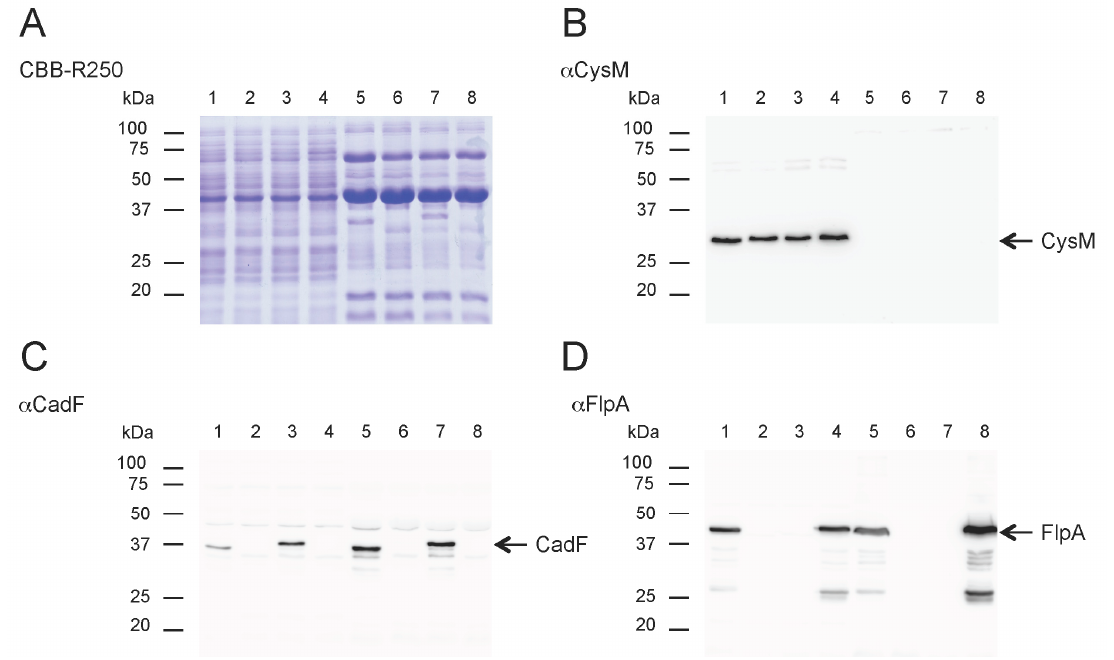
Figure 4. CadF and FlpA are localized in the outer membrane protein (OMP) extracts of the C. jejuni transformed isolates. C. jejuni whole-cell lysates (WCL) and OMP extracts from C. jejuni wild-type, the ∆ cadF ∆ flpA isolate, and the ∆ cadF ∆ flpA isolate complemented with cadF or flpA were subjected to SDS-PAGE and immunoblot analysis with rabbit α -CadF, α -FlpA, and α -CysM-specific sera. Panels: ( A ) proteins were stained with Coomassie Brilliant Blue R-250 (CBB-R250) to show equal loading; ( B ) immunoblot probed with the α -CysM serum, a cytosolic protein used to assess the purity of the OMP extracts; ( C ) immunoblot probed with the α -CadF serum; and ( D ) immunoblot probed with the α -FlpA serum. Lanes: C. jejuni strains (1) 81-176 (wild-type), WCL; (2) ∆ cadF ∆ flpA , WCL; (3) ∆ cadF ∆ flpA :: P cadF-400 bp cadF -FLAG, WCL; (4) ∆ cadF ∆ flpA :: P flpA flpA , WCL; (5) 81-176 (wild-type), OMP; (6) ∆ cadF ∆ flpA , OMP; (7) ∆ cadF ∆ flpA :: P cadF-400 bp cadF -FLAG, OMP; (8) ∆ cadF ∆ flpA :: P flpA flpA , OMP. The position of the CysM (32 kDa), CadF (37 kDa), and FlpA (46 kDa) proteins are highlighted with arrows. The positions of the molecular mass standards (in kDa) are indicated on the left.